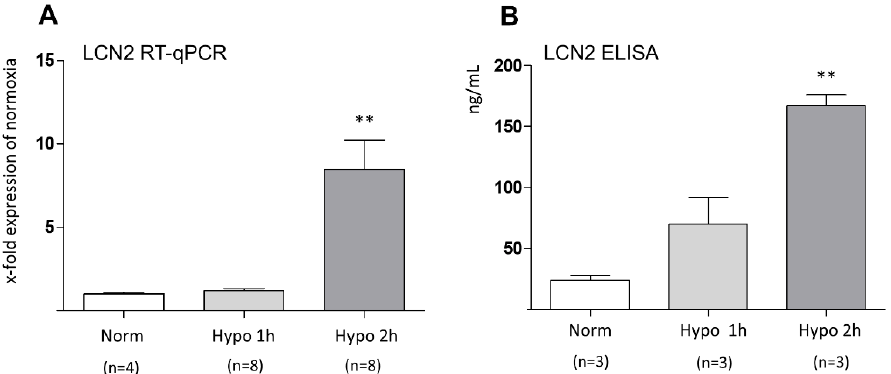
Figure 3. Effect of hypoxia on ( A ) LCN2 gene expression and ( B ) protein levels of LCN2 in cultured primary astrocytes isolated from the cerebral cortex. ( A ) RT-qPCR analysis reveals a significant increase in LCN2 mRNA levels at 2 h post hypoxia. ( B ) LCN2 protein concentrations measured in supernatant of cultured hypoxic astrocytes at 2 h post hypoxia also shows a significant upregulation of LCN2. * p ≤ 0.05, ** p ≤ 0.01, and *** p ≤ 0.001. Norm, normoxia; Hypo, Hypoxia.